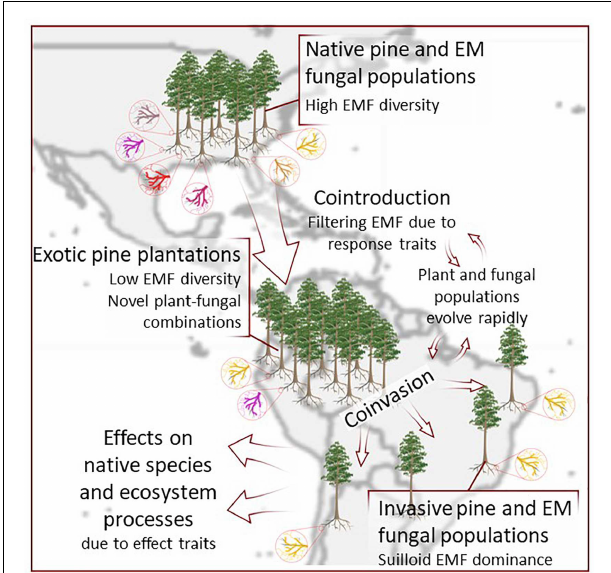
FIGURE 3 | Introduction of pines and ectomycorrhizal fungi (EMF) leads to reduction of EMF diversity in exotic plantations compared to the native range, and novel combinations of pines and fungi from the Northern Hemisphere. Co-invasion out of plantations into native habitats leads to dominance of Suilloid EMF. Effect traits of EMF in plantations and invaded areas may drive effects for native species and ecosystems, and those effects may be modified by rapid